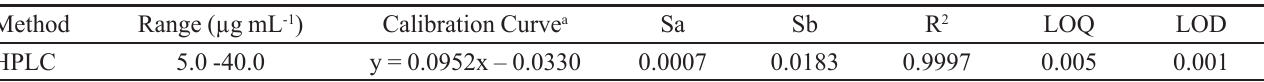
TABLE IV - Linearity of RIV analyses by the developed method